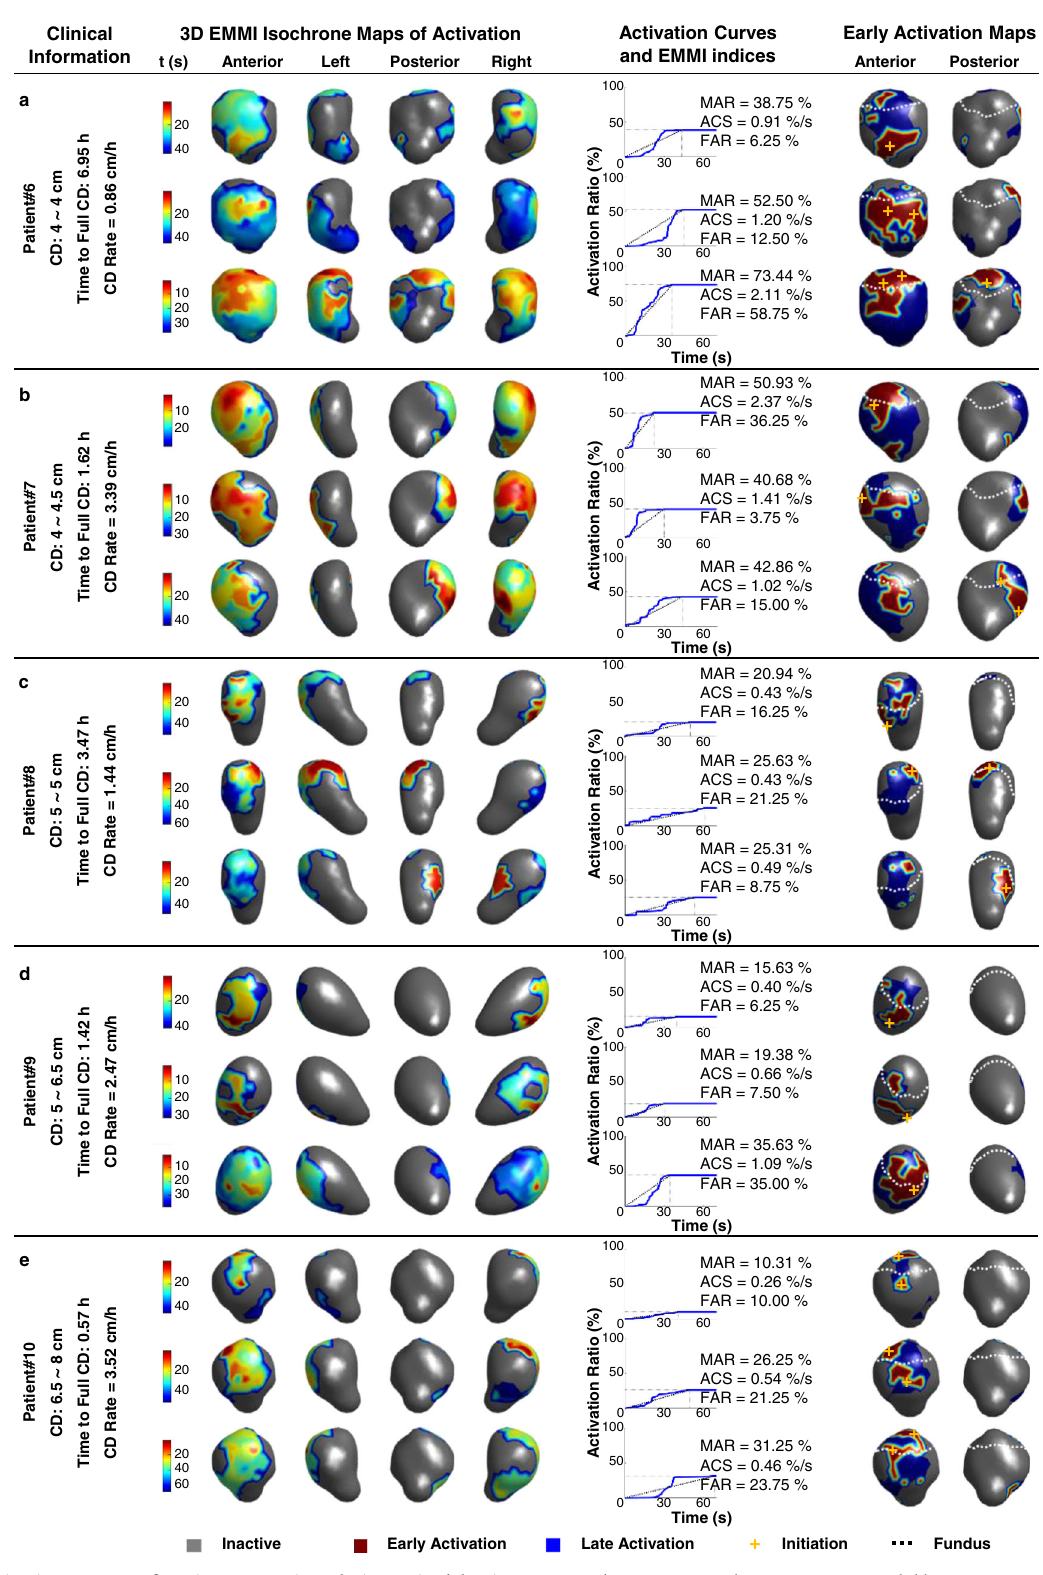
Fig.5|EMMIactivationpatternsofuterinecontractionsduringactivelaborin multiparous women. a In Subject #6, the cervical dilation remained at 4cm and reached 10cm in 6.95h after the EMMI recording was completed. b – e Results for Subjects #7, #8, #9, and #10. Same format with Subject #6. 3D three-dimensional,